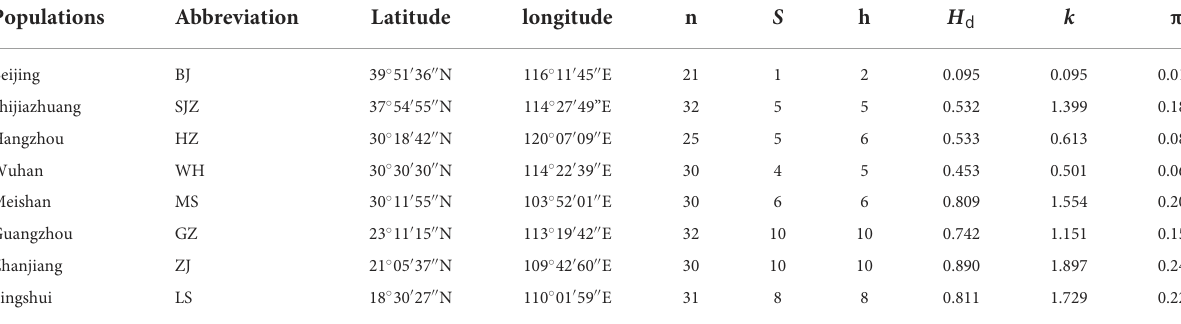
TABLE 1 Population information and genetic polymorphism based on cox 1 of Ae. albopictus in China.